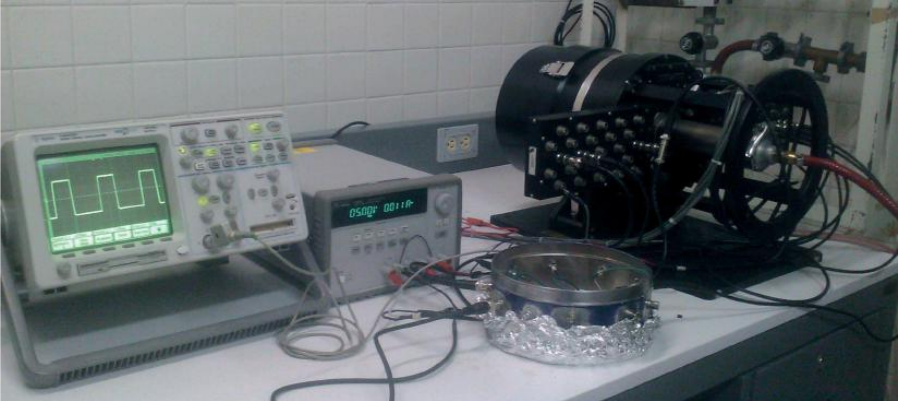
Figure 9. Experimental